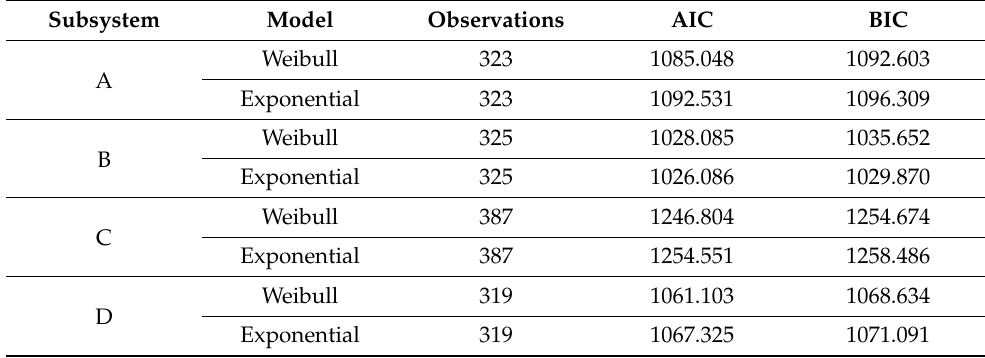
Table 7. The results of AIC and BIC goodness of fit tests for classical model